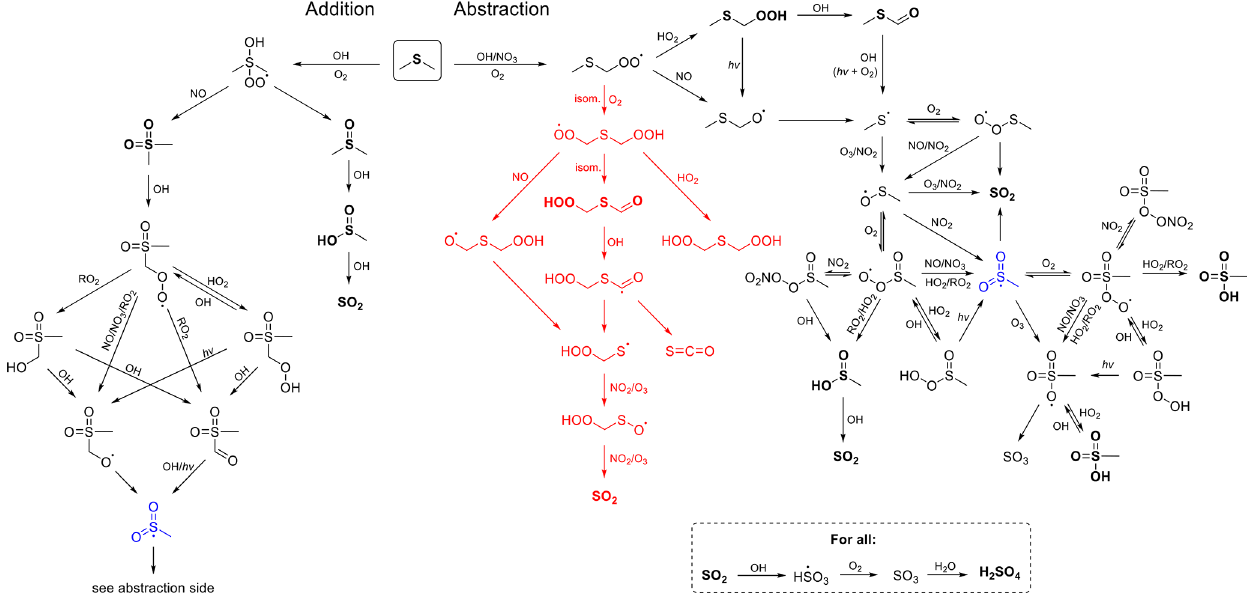
Figure 1. Gas-phase DMS + OH oxidation mechanism. Measured closed-shell products are shown in bold. Reactions in black are taken from MCM (Master Chemical Mechanism); reactions in red, related to hydroperoxymethyl thioformate (HPMTF, HOOCH 2 SCHO) chemistry, are taken from Wu et al. (2015). Products that do not contain sulfur are not shown. The CH 3 SO 2 radical (marked in blue) represents a link between addition and abstraction pathway products. Note that several products are shown multiple